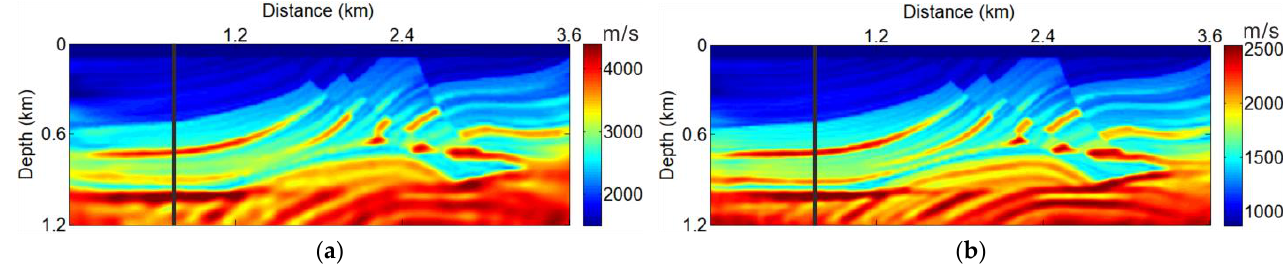
Figure 11. High-frequency data (5 – 10 Hz) based EFWI results using Figure 10 as the initial velocity model; ( a ) V p ; ( b ) V s .